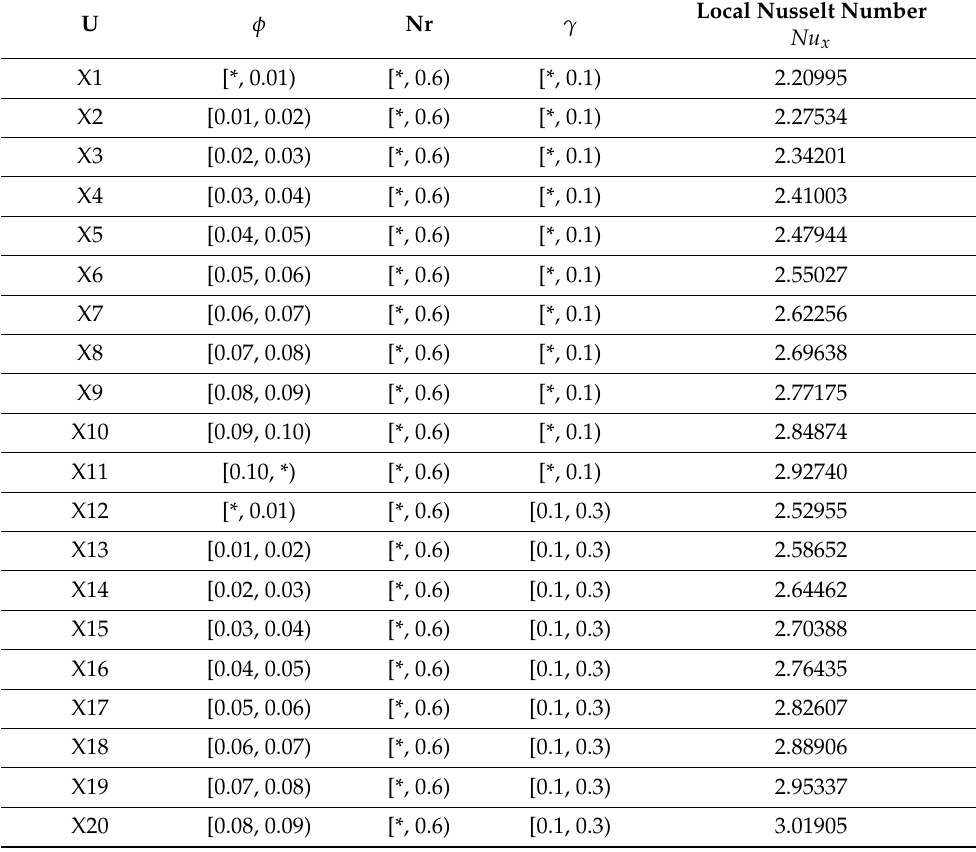
Table 3. The discretized decision table of Table